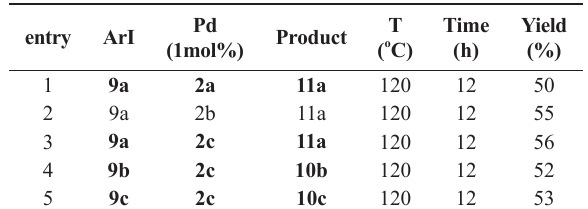
Yields and main conditions for the reaction shown in Figure